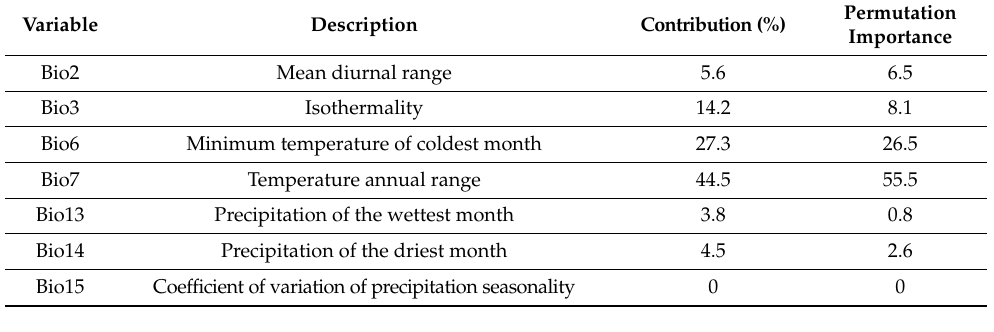
Table 4. Contribution rates of seven environmental variables.